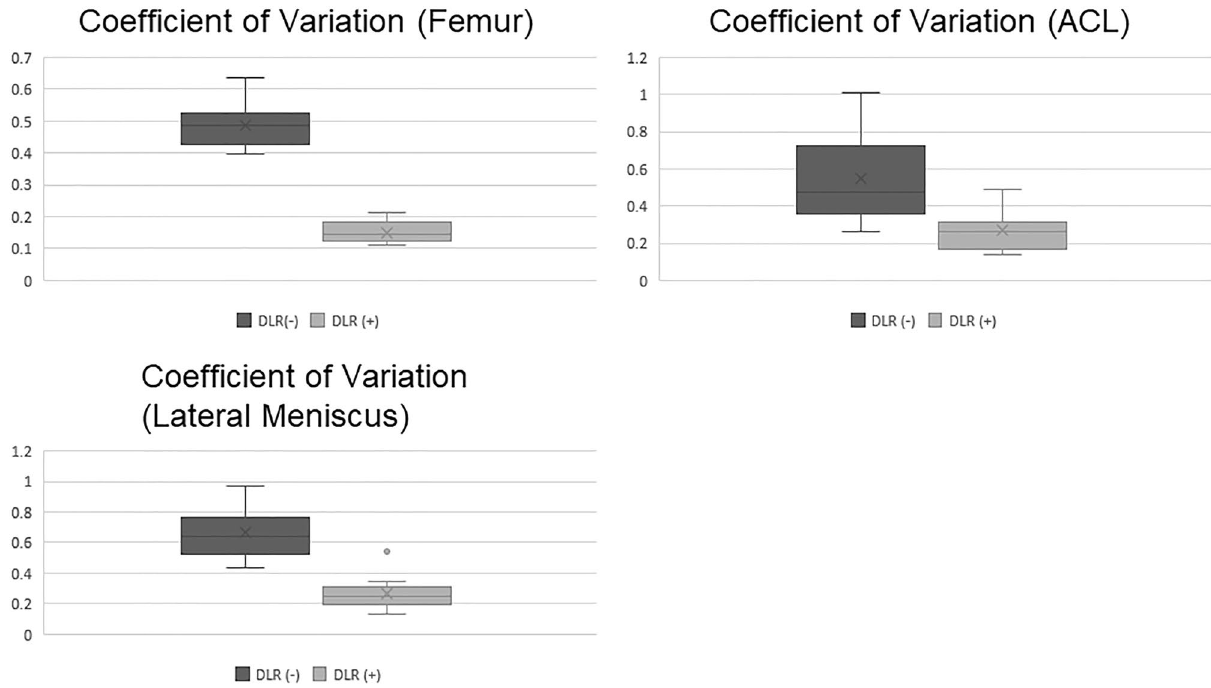
Figure 2. Results of CV measurement of the femur, the pars intermedia of the lateral meniscus and ACL in coronal thin-slice 2D FS-PDWI before and after the adaptation of dDLR. The CV after dDLR was significantly lower than that before dDLR at all sites ( p < 0.05, p < 0.05, and p < 0.05, respectively). CV indicates coefficient of variation; ACL, anterior cruciate ligament; 2D FS-PDWI, 2-dimensional fat saturated-proton density weighted image; dDLR, denoising approach with deep learning-based